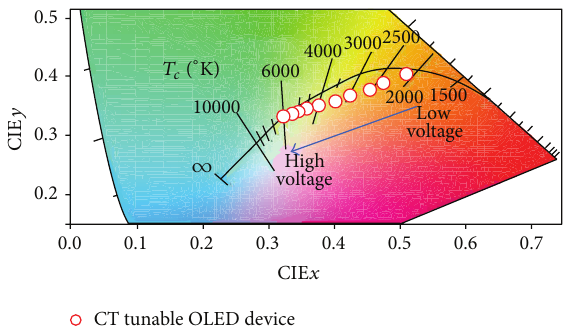
Figure 2: Chromaticity and color temperature characteristics of the color temperature tunable OLED, which shows a dusk hue-style emission at low applied voltage and bluish white day light-style emission at high voltage. A record high color-temperature span is observed for the device without using any additional CML.